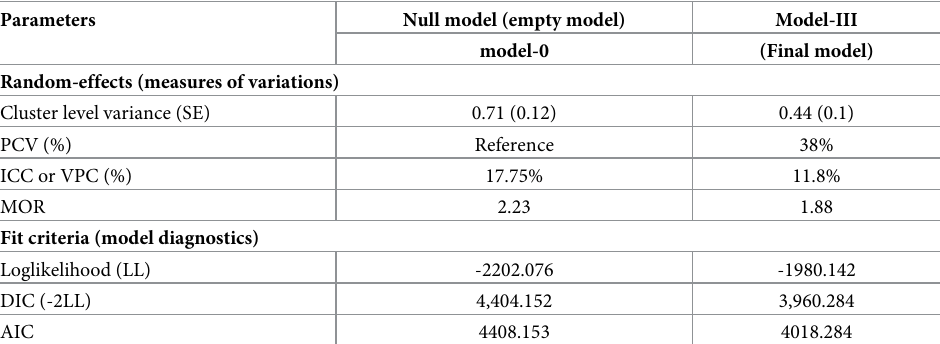
Table 4. Random effects (measures of variations) and model fitness for no ASF consumption among children at primary sampling units (clusters) level by a multilevel mixed-effects logistic regression modeling based on pooled data from Ethiopia DHS 2016 &